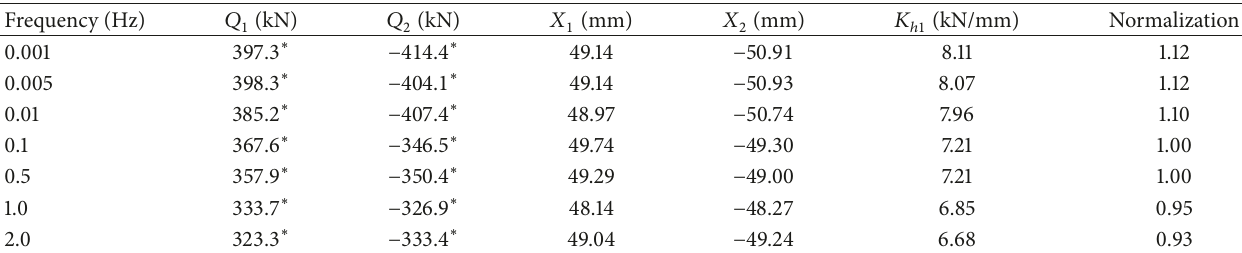
Table 5: Test results of 𝐾 ℎ1 in different loading frequency.